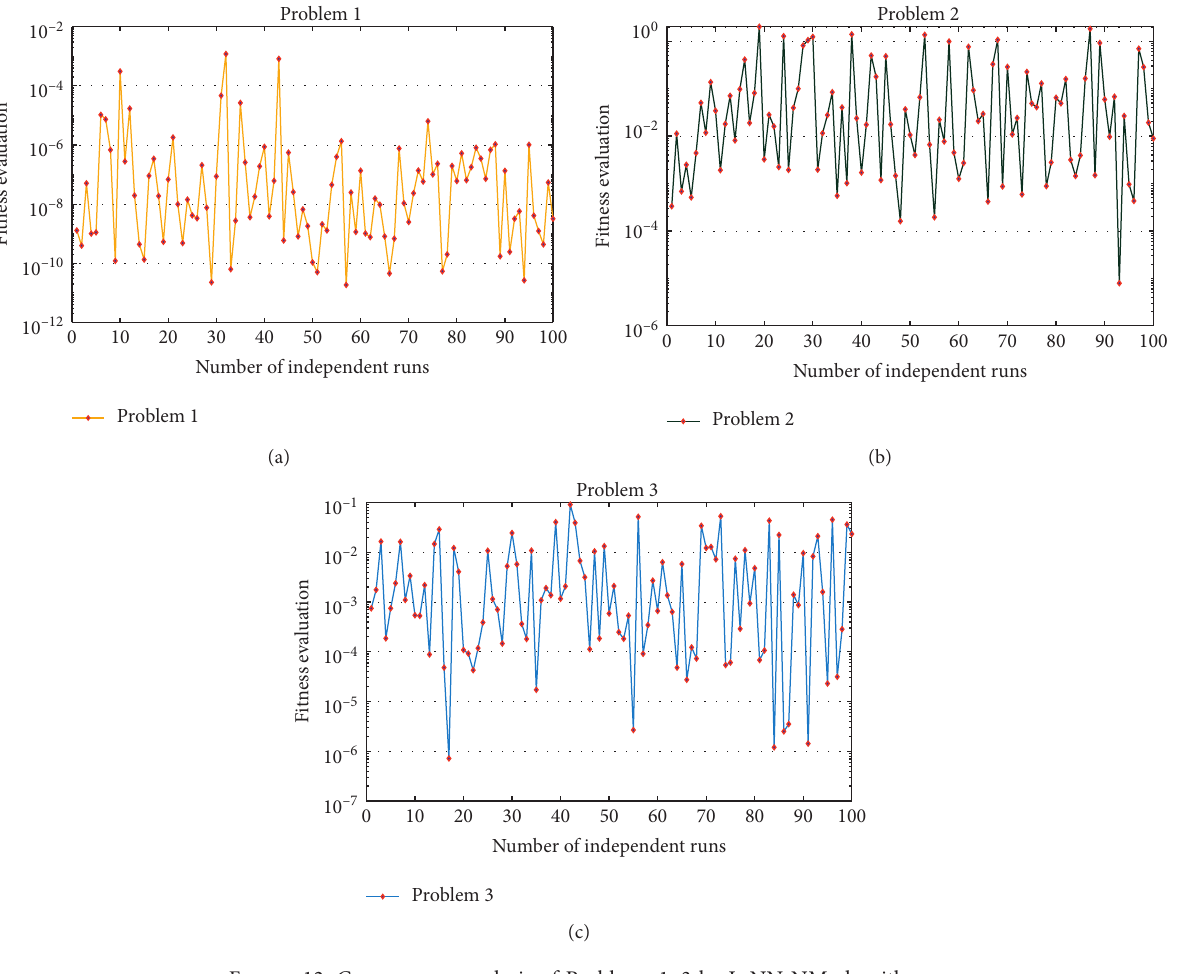
Figure 12: Convergence analysis of Problems 1–3 by LeNN-NM